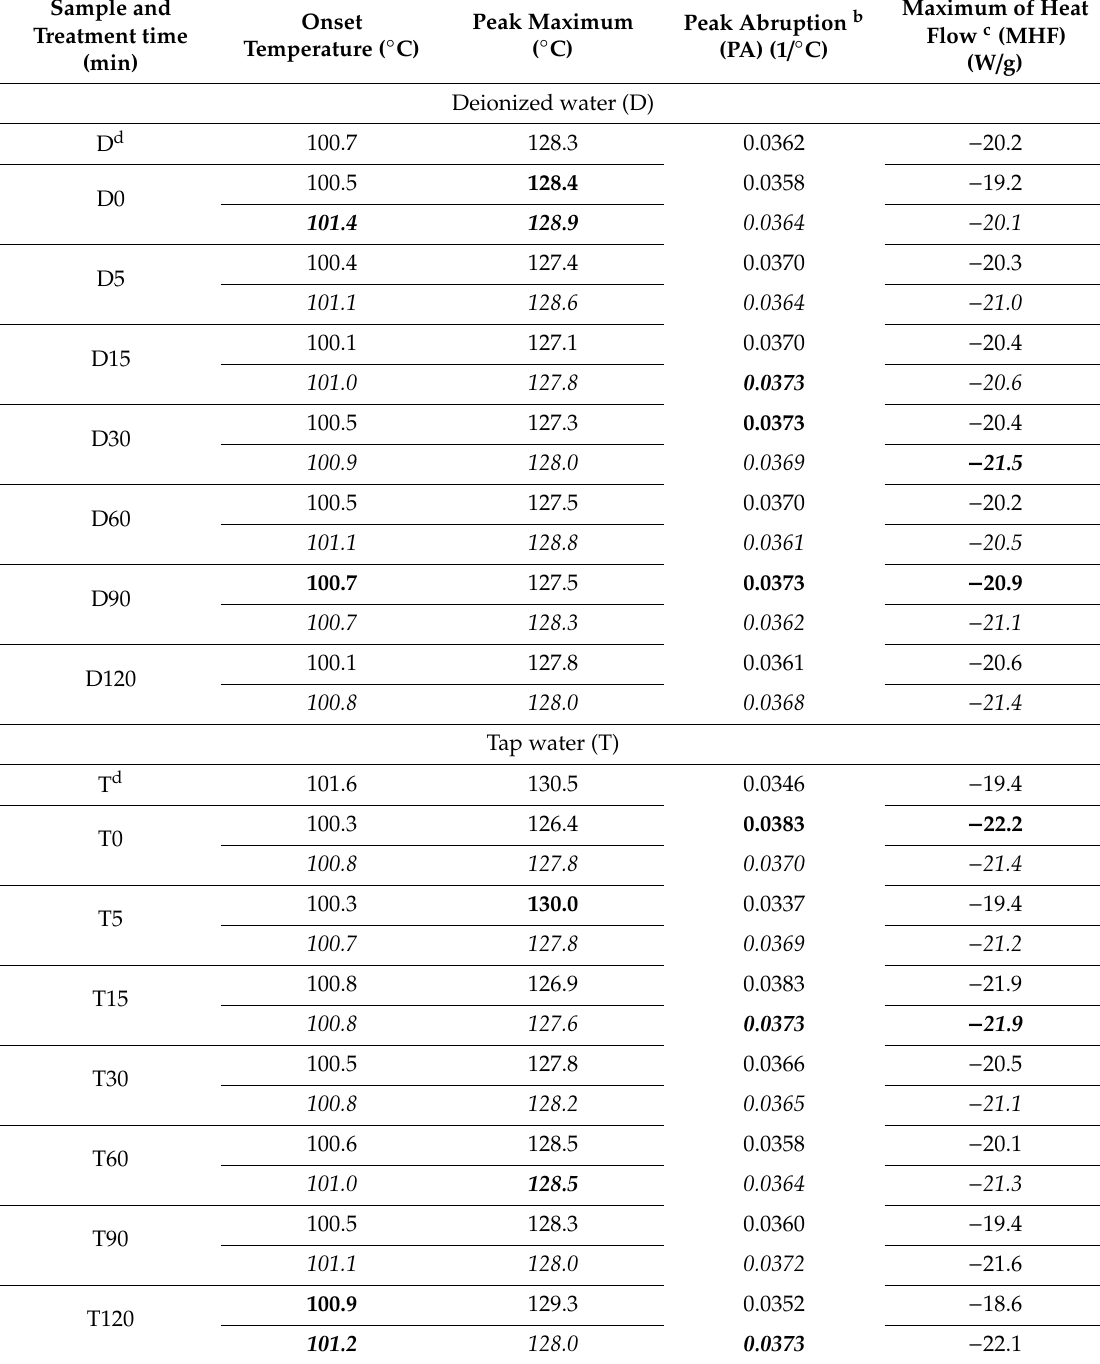
Table 8. DSC characteristics of deionized and tap water treated with LPGP a . Sample